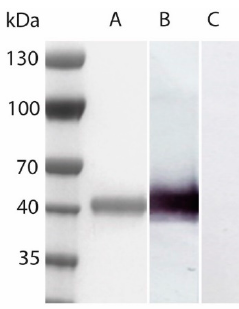
Figure 1. Purified native secreted glycoprotein G (sgG-2) (10 µ g) was visualized by Coomassie blue staining after separation by SDS-PAGE ( A ). The sgG-2 protein was readily detected in Western blot using an anti-sgG-2 monoclonal antibody (MAb) ( B ), but undetectable using a mix of anti-mgG-2, anti-gB, anti-gC and anti-gD MAbs ( C ). sgG-2 was identified with an estimated molecular mass of 42